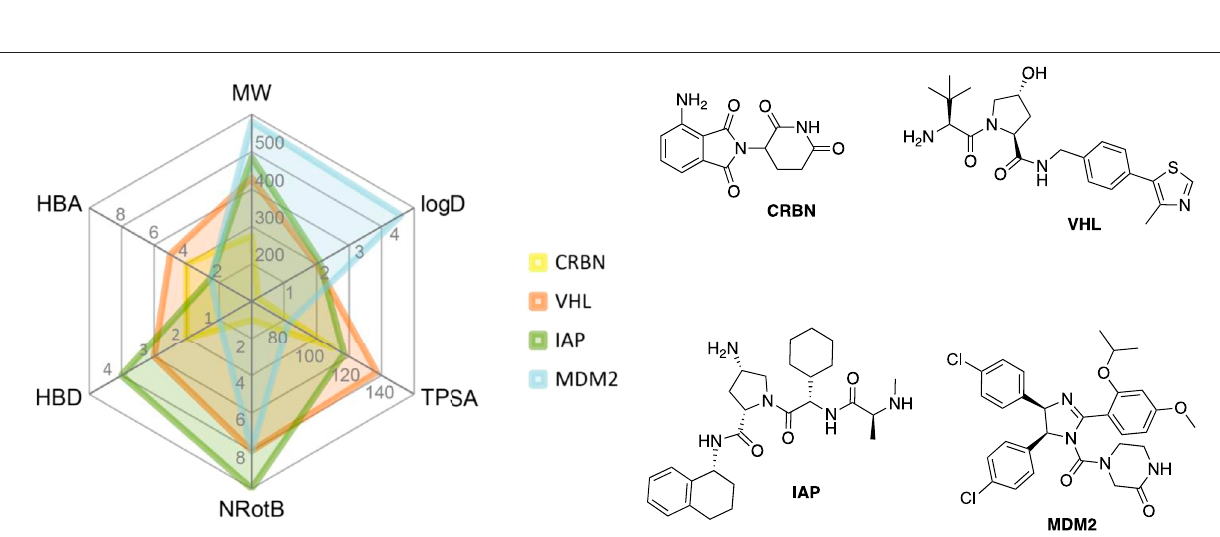
Frontiers in Chemistry |